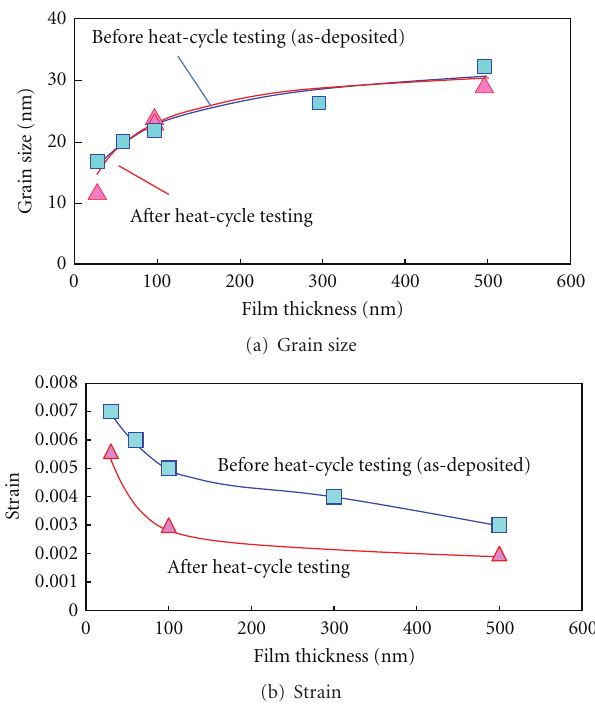
Figure 9: Average grain size and strain in the in-plane direction ( a -axis of Wurtzite cell) as a function of film thickness. Wurtzite crystalline cells oriented strictly along the normal direction to the surface of the